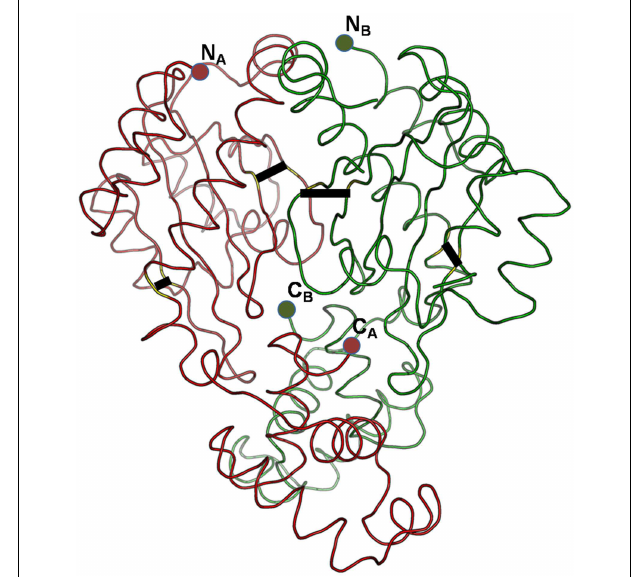
FIGURE 4 | Potential disulfide bridges in the Burkholderia pseudomallei solo LuxR proteins which form one clade on phylogenetic tree (Figure 2). Four potential disulfide bridges are mapped on the X-ray structure of the active conformation of the TraR dimer, which was crystallized along with the autoinducer (not shown) and target DNA (not shown) (PDB code: 1H0M). The four bridges are (from left to right): A48–A169, A82–A116, B82–B116, and